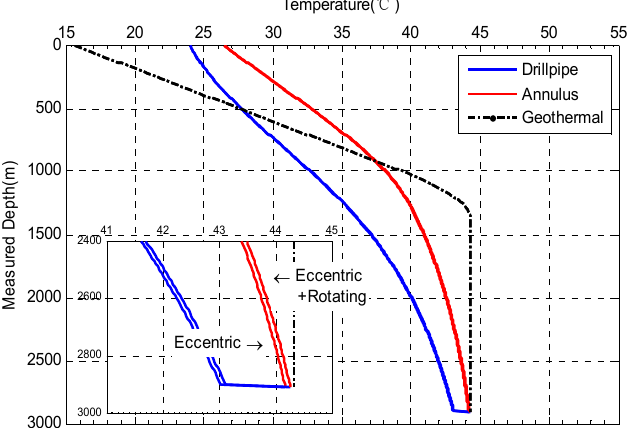
Figure 6. Comparison between temperature profiles with eccentric drill pipes and with concentric drill pipes (Eccentricities: e = 0.6 for vertical section, e = 0.62 for inclined section and e = 1 for horizontal section).